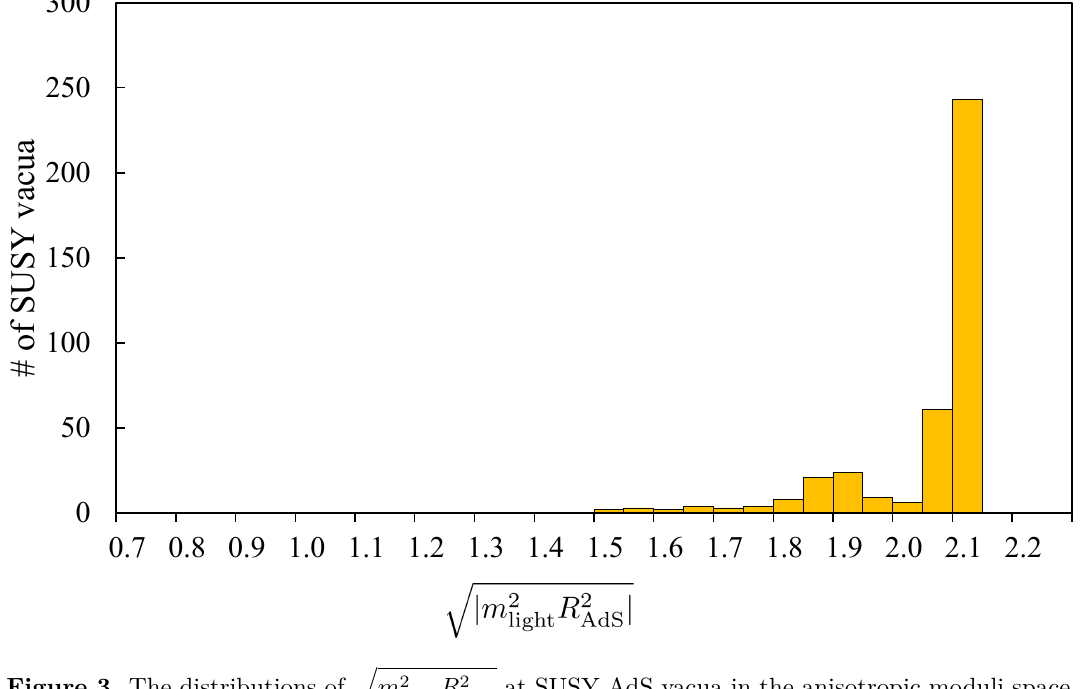
q at SUSY AdS vacua in the anisotropic moduli space. m 2 R 2 light AdS